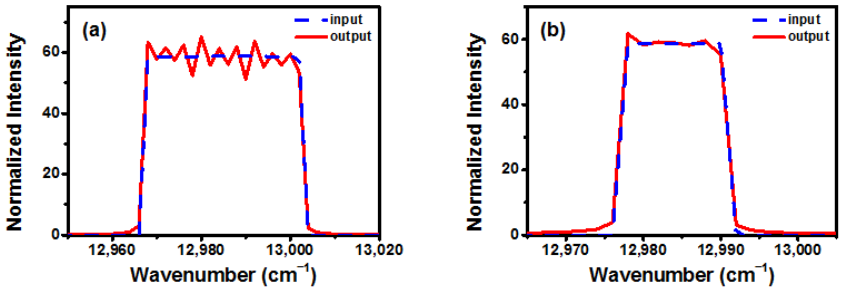
Figure 11. Spectrum of the input and response of ( a ) pump and ( b ) probe pulse. The spectra of the input pump and probe pulses are both multiplied by 58.7 times.